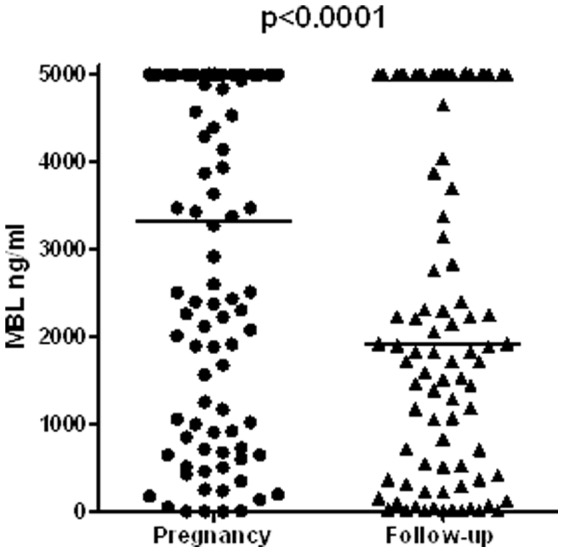
Comparison of serum MBL levels in the first trimester of pregnancy and after delivery in 96 women positive screened for TPOAb and/or thyroid dysfunction in pregnancy.Median interval between delivery and follow-up was 17 months, range 3–78. Wilcoxon signed rank test.